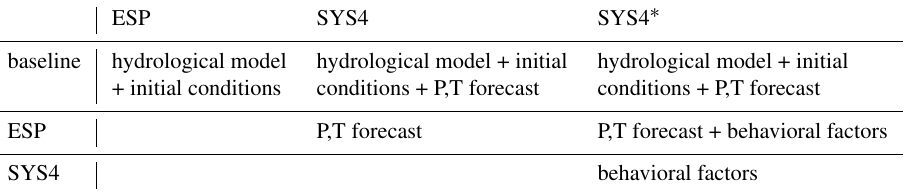
Table 1. Benchmarking matrix to isolate the sources of forecast value: baseline is the observed climatology; ESP is the ensemble streamflow prediction of E-HYPE; SYS4 is the prediction generated by using dynamical precipitation and temperature forecasts as input for E-HYPE; and SYS4 ∗ replaces the ensemble mean used in SYS4, with different statistics capturing increasing levels of drought risk aversion.